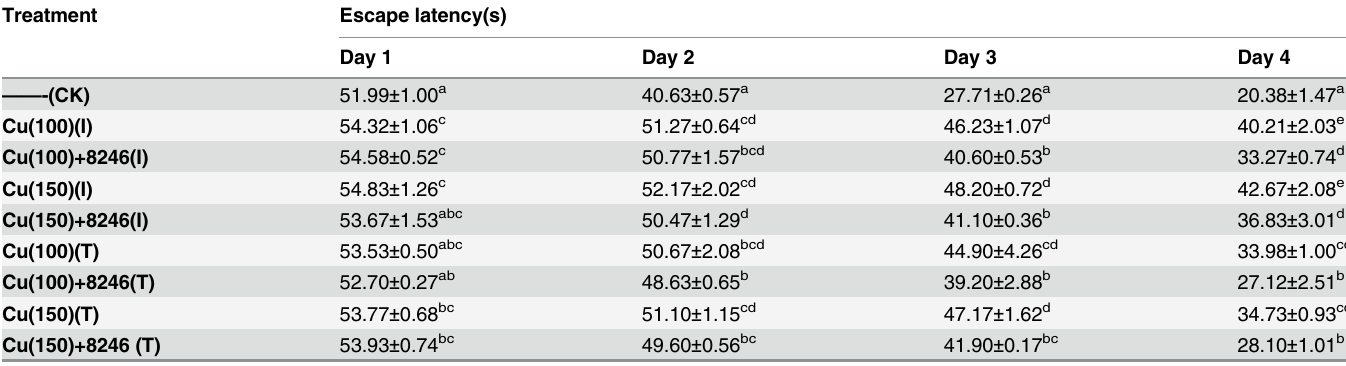
Table 4. The results of Morris water maze experiment (navigation training for spatial orientation).